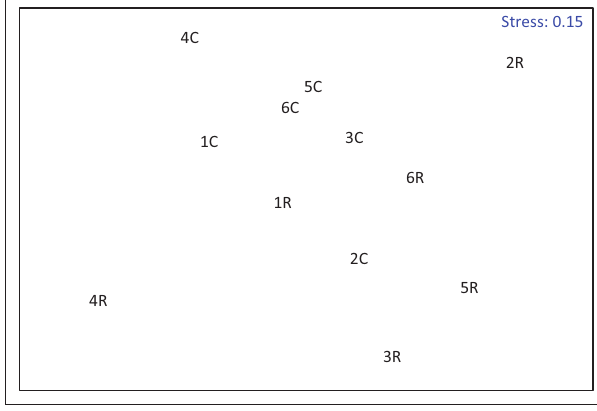
2C3C4C 1C FIGURE 3: Non-metric multidimensional scaling plot indicating the similarity of ant assemblages among replicates of control and rehabilitated sites.